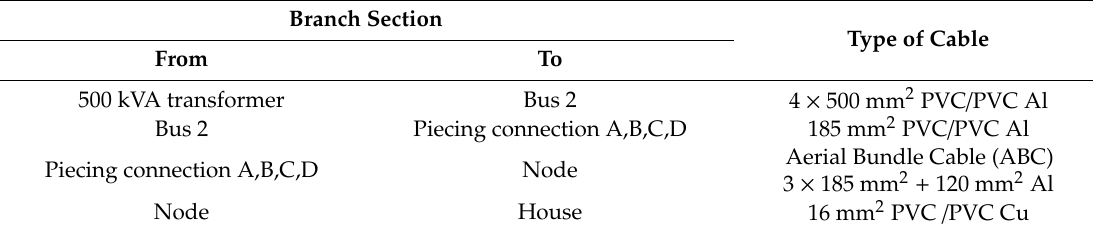
battery energy storage system). Table 1. Size and types of cable used in the network.